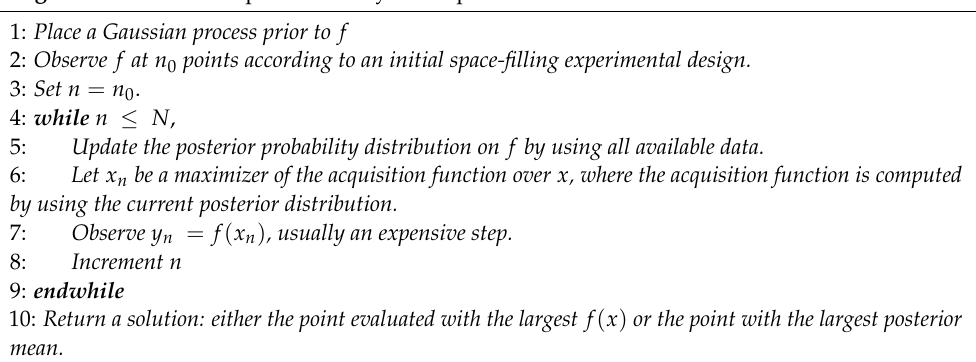
Algorithm 1: The main process of Bayesian